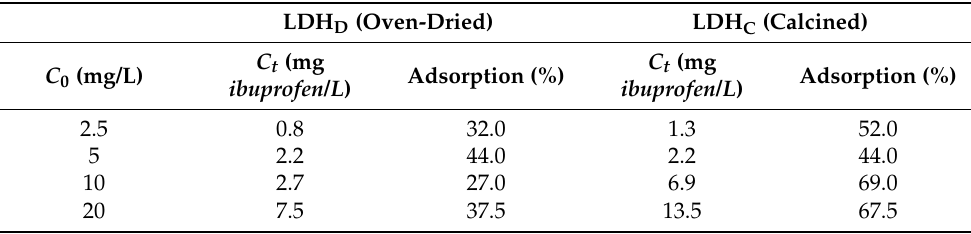
Table 2. Adsorption results for hydrotalcite when testing ibuprofen solutions from 2.5 to 20 mg/L. Adsorption refers to the percentage of ibuprofen retained by the solid with respect to the initial concentration in the solution. Variation coefficients (%) of triplicates were under 10% in all cases.